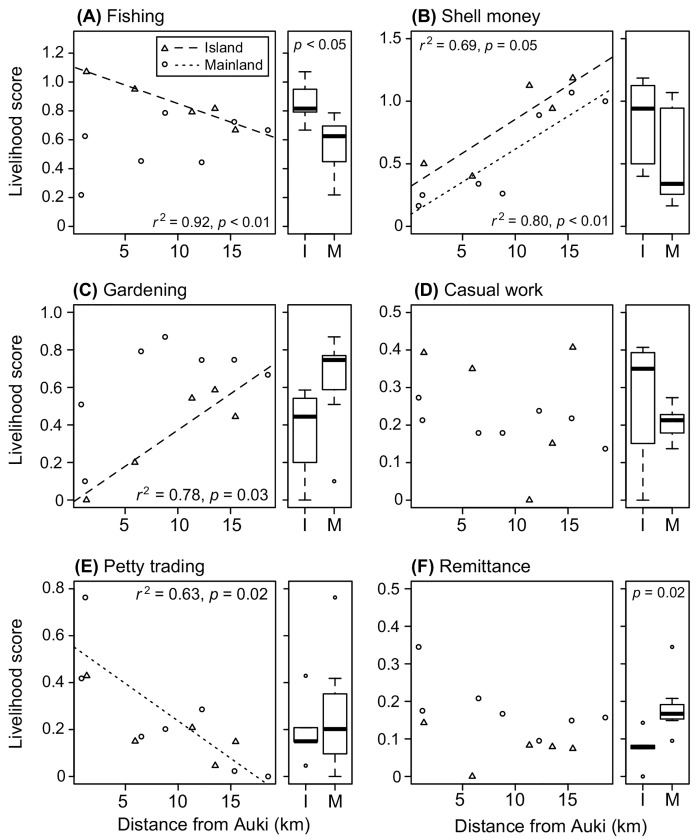
Significance of distance from Auki on livelihood activities.Relationship between weighted mean livelihood importance score (Li) and distance from Auki (km) for the six most-common livelihood activities. Differences in slopes were detected for fishing, shell money, gardening and petty trading (panels A, B, C and E). The Tukey’s boxplots illustrate the range, median and upper and lower quartiles of Li at island (I) and mainland (M) households for each of the six most common livelihood activities. Significant difference in Li between island and mainland households was found for fishing (panel A), and remittance (panel F).